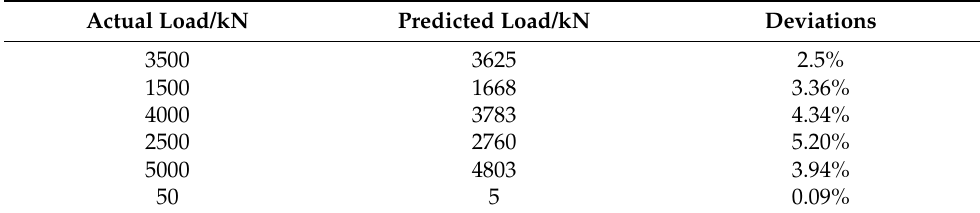
Figure 11. Influence of iteration number on the performance of BPNN. Table 2. The predicted load by the trained NN and the deviations. Actual Load/kN Predicted Load/kN